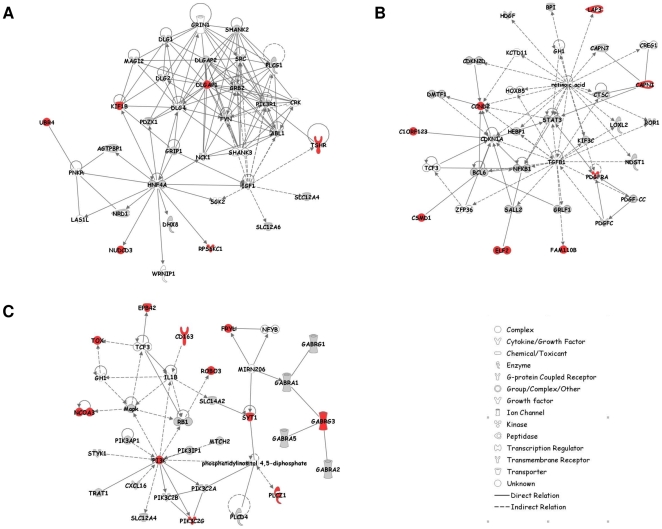
Representation of the gene networks N_MON (A), N_NOR (B) and N_HOL (C).Symbols corresponding to candidate genes are colored in red. Genes colored in grey were represented in our study but did not display any evidence of selection.